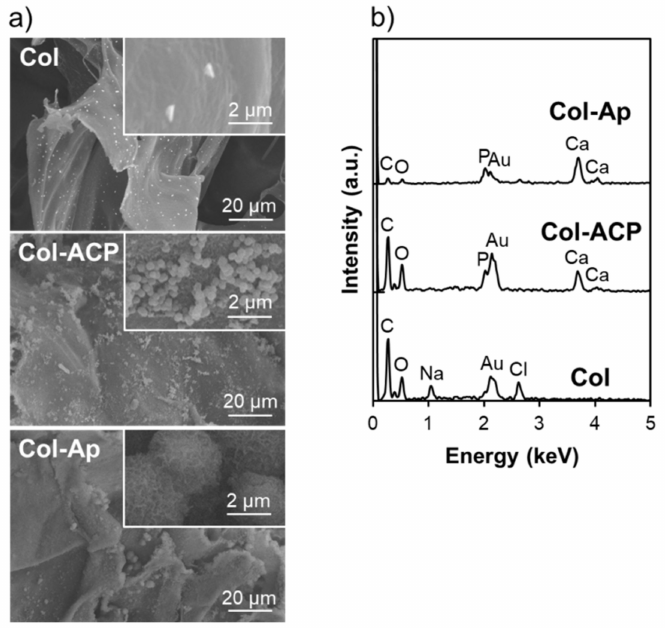
Figure 1. ( a ) SEM images; ( b ) EDX spectra of Col, Col-ACP, and Col-Ap surfaces. Insets in ( a ) show magnified images.